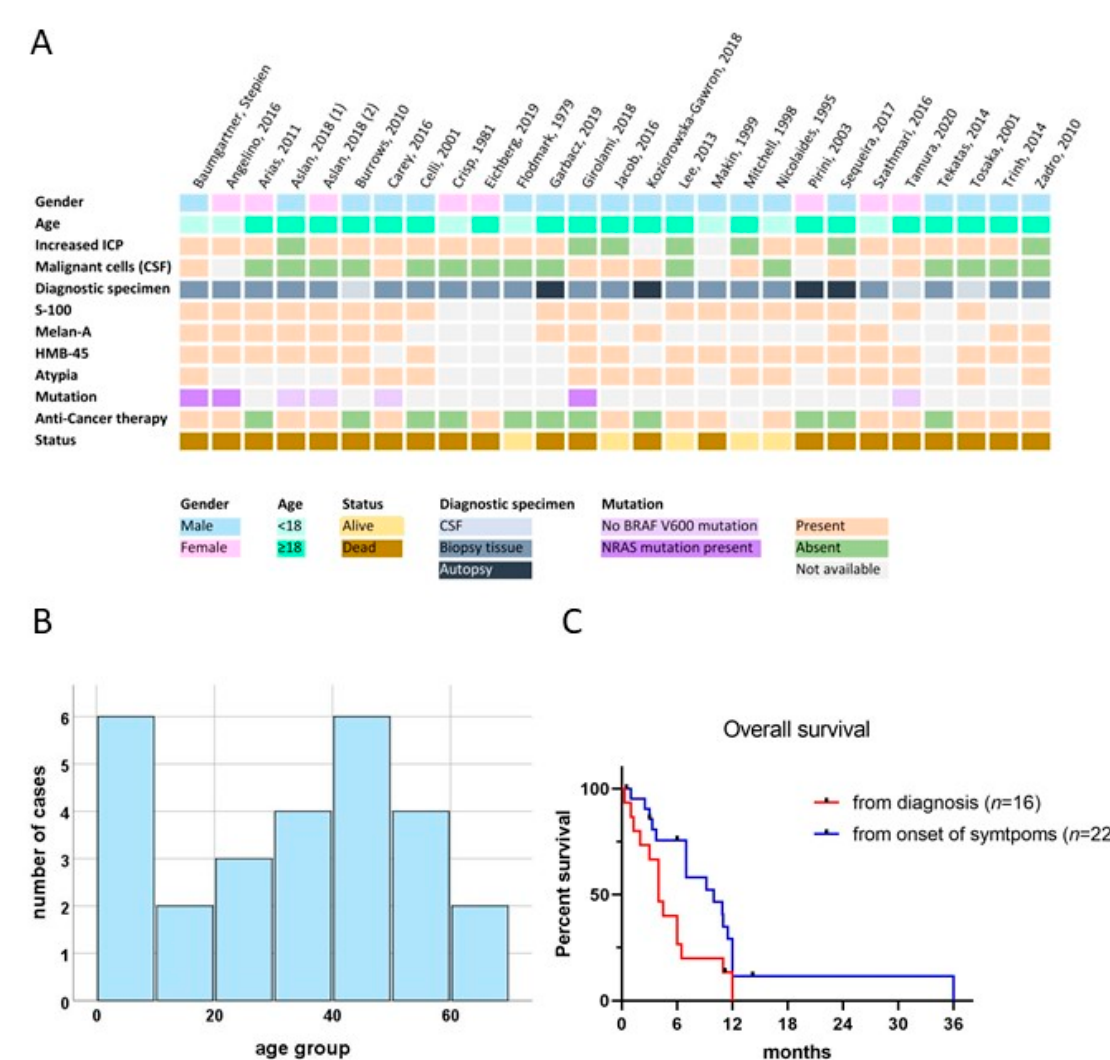
Figure 4. Results of the comprehensive literature review, including survival data and demographic properties. ( A ): Integrative overview of demographics, clinical, cytological, histological, and molecular findings of cases of PDLMM reported in literature, including our illustrative case. ( B ): Age histogram showing the bimodal age distribution. ( C ): Kaplan Meier curve for survival from diagnosis (red) and from onset of symptoms (blue). Patients alive at time of reporting were censored at latest mentioned time point.